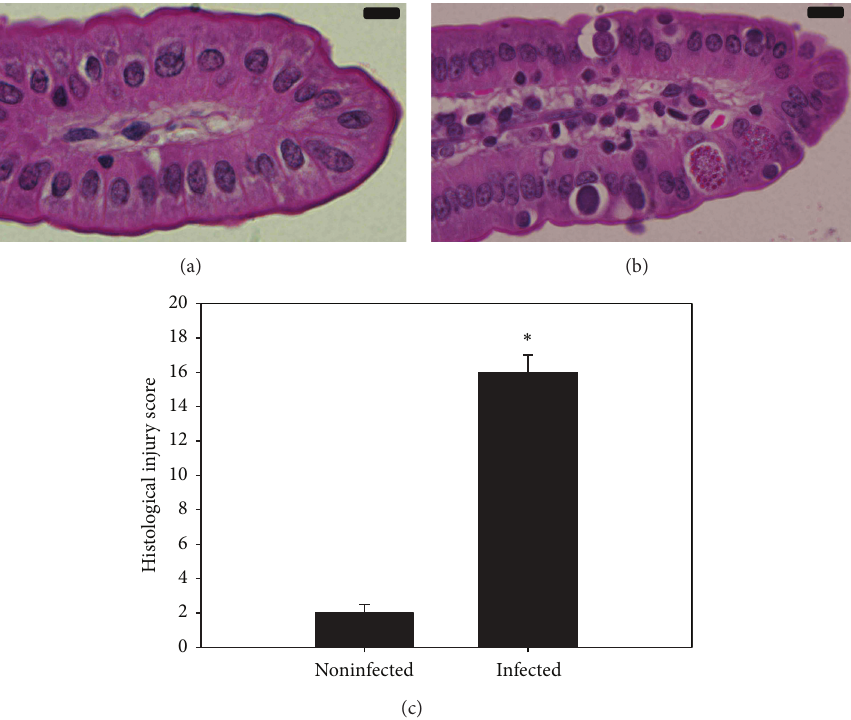
Figure 1: E. papillata -induced jejunum injury on day 5. (a) Noninfected jejunum with normal architecture of the absorptive epithelium and lamina propria. (b) Infected jejunum with some pathological changes in lamina propria and absorptive epithelia. Developmental stages appearing in the absorptive epithelia. Sections are stained with hematoxylin and eosin. Bar = 25 𝜇 m. (c) Total histological injury score in jejunum of mice infected with E. papillata on day 5 p.i. Values are means ± SD. ∗ Significant at 𝑃 ≤ 0.05 . 𝑛 = 10